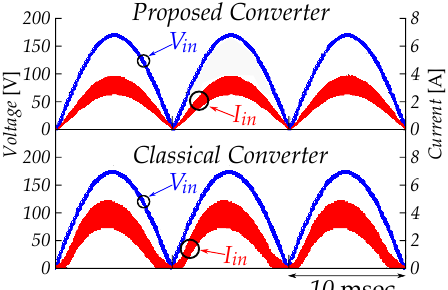
Figure 6. Comparison under the condition of minimum power and maximum output